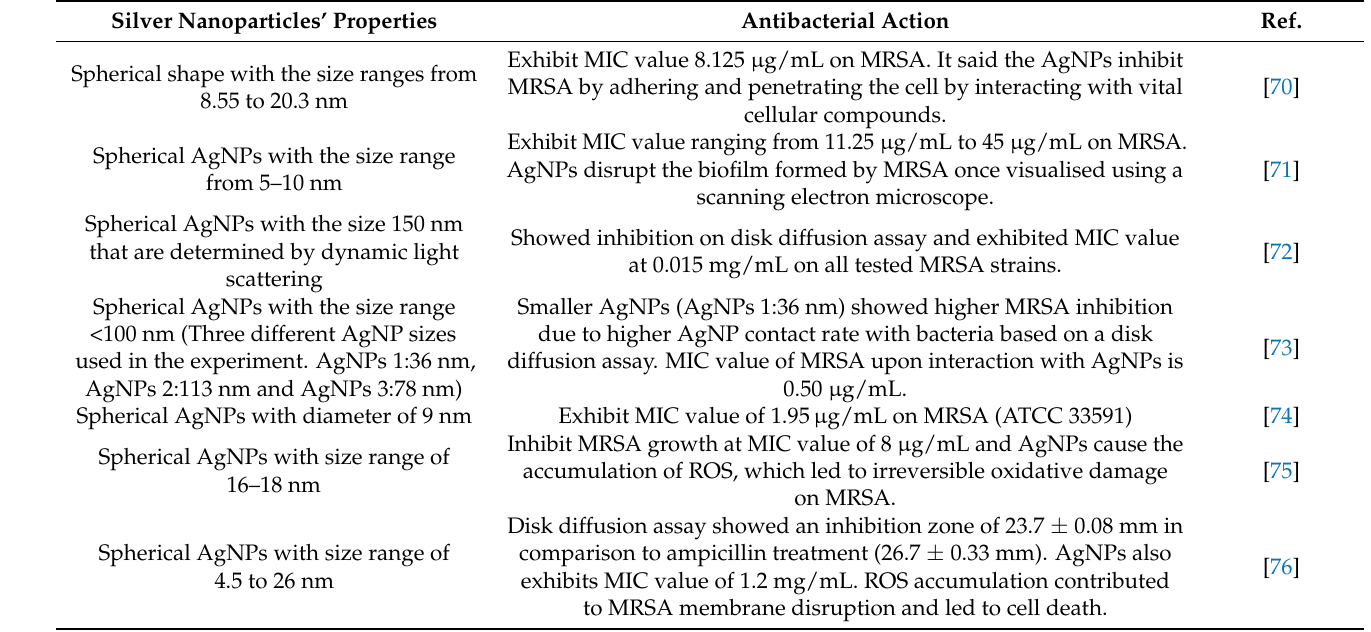
Table 2. Antibacterial effect of AgNPs on